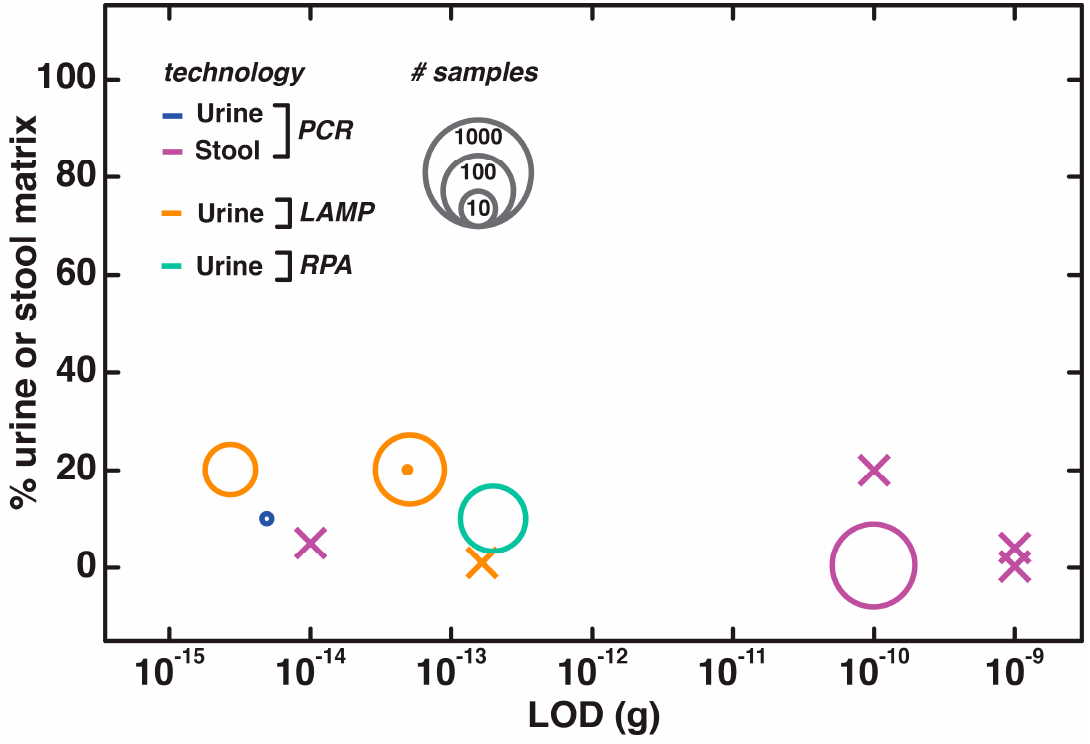
Figure 8. Nucleic acid testing in fecal and urine samples, with data presented as in Figure 3.